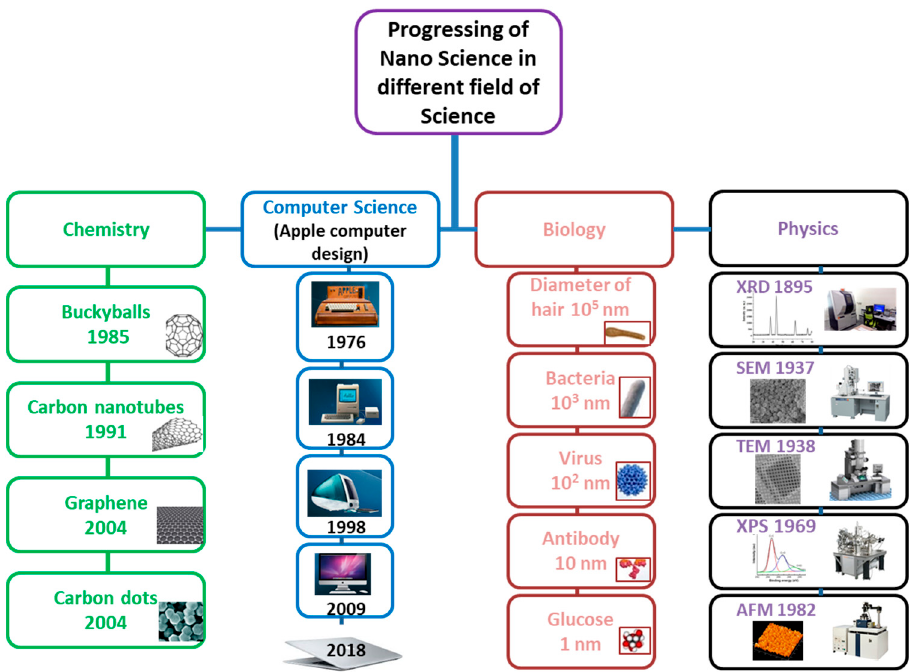
Figure 9. Progress in nanoscience and nanotechnology in different fields of science.